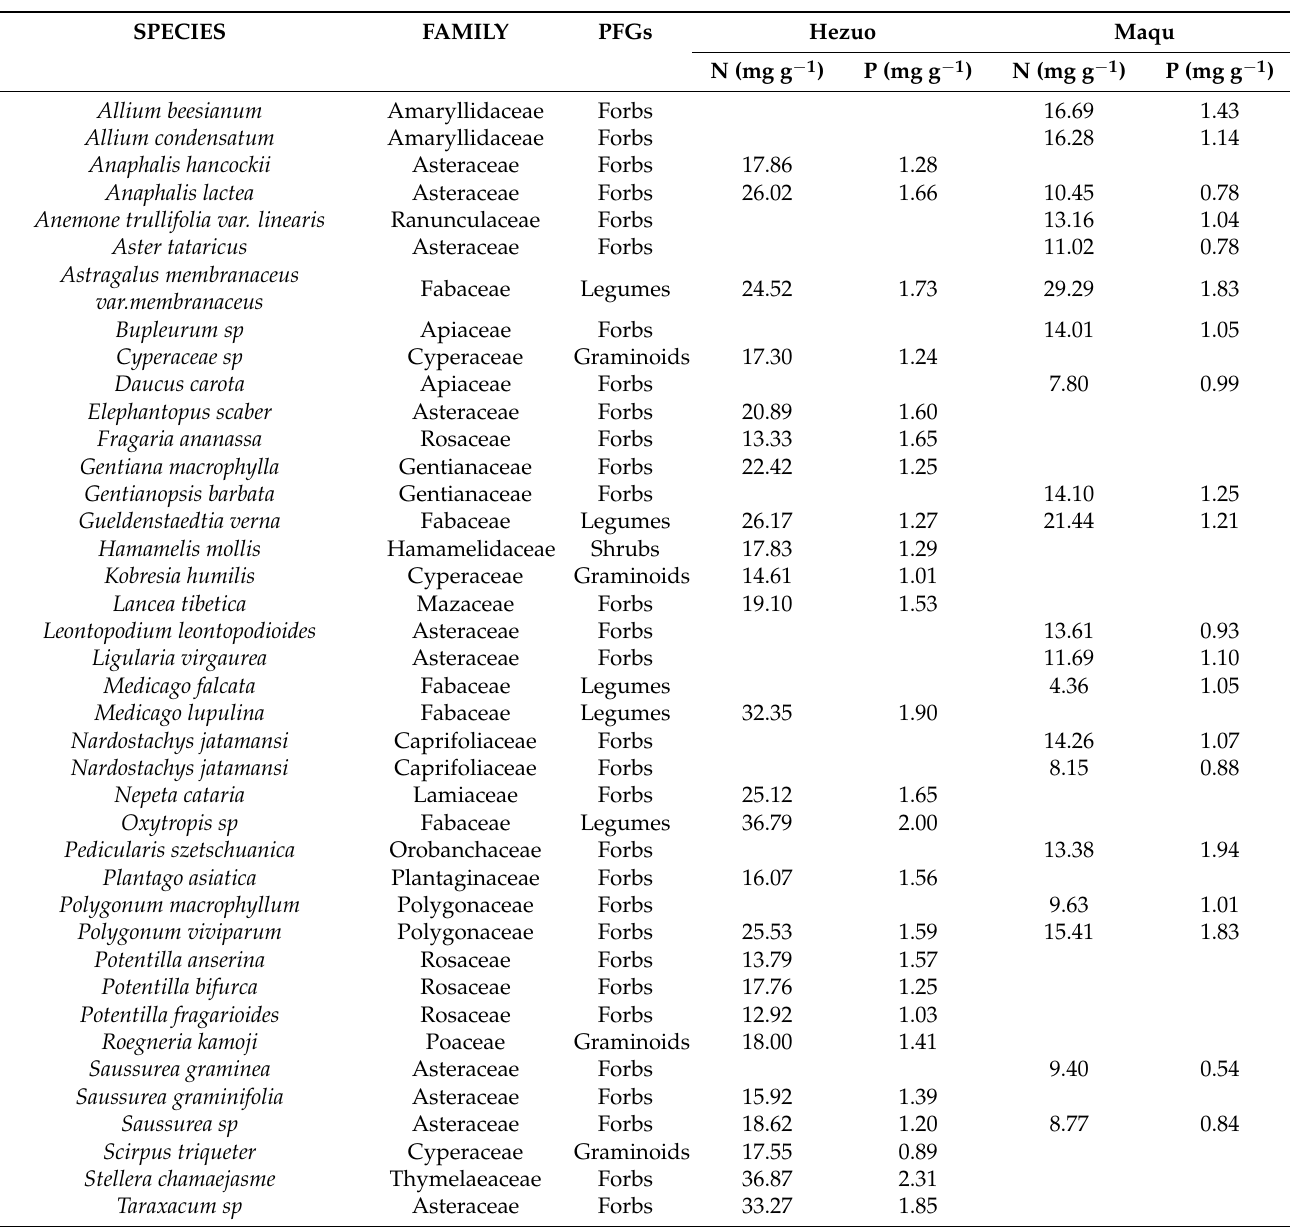
Table 1. Mean value of leaf nitrogen (N) and phosphorus (P) concentrations of the 40 measured species. PFG represents plant functional